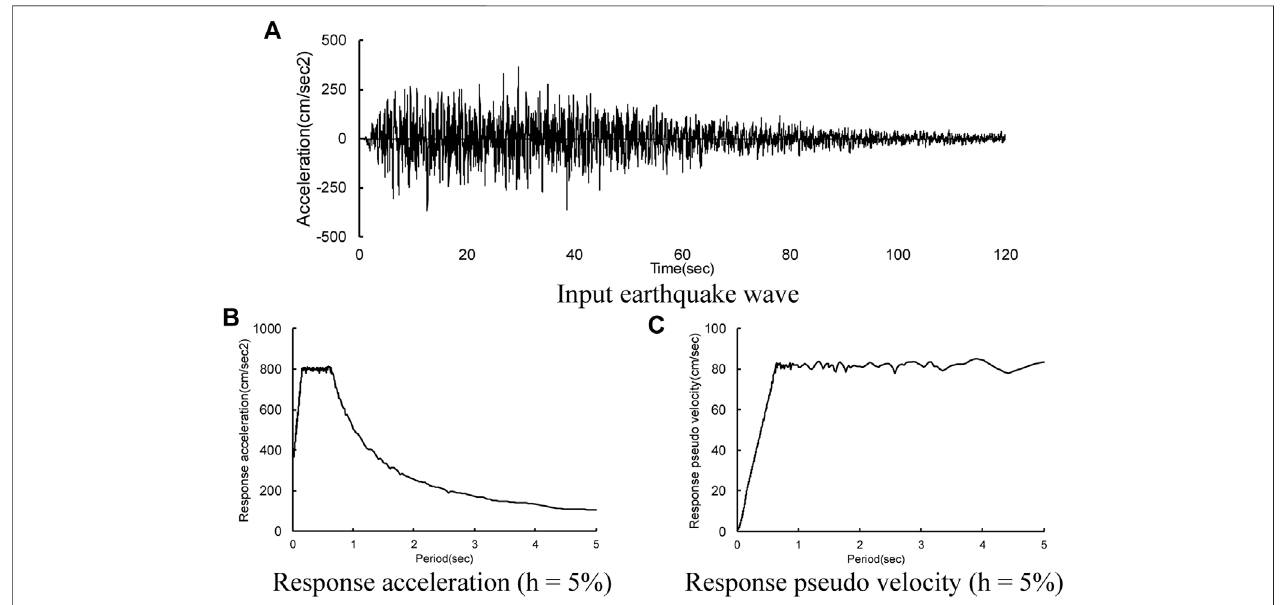
FIGURE 5 | Simulated earthquake motion. (A) Input earthquake wave, (B) Response acceleration (h = 5%), (C) Response pseudo velocity (h = 5%).